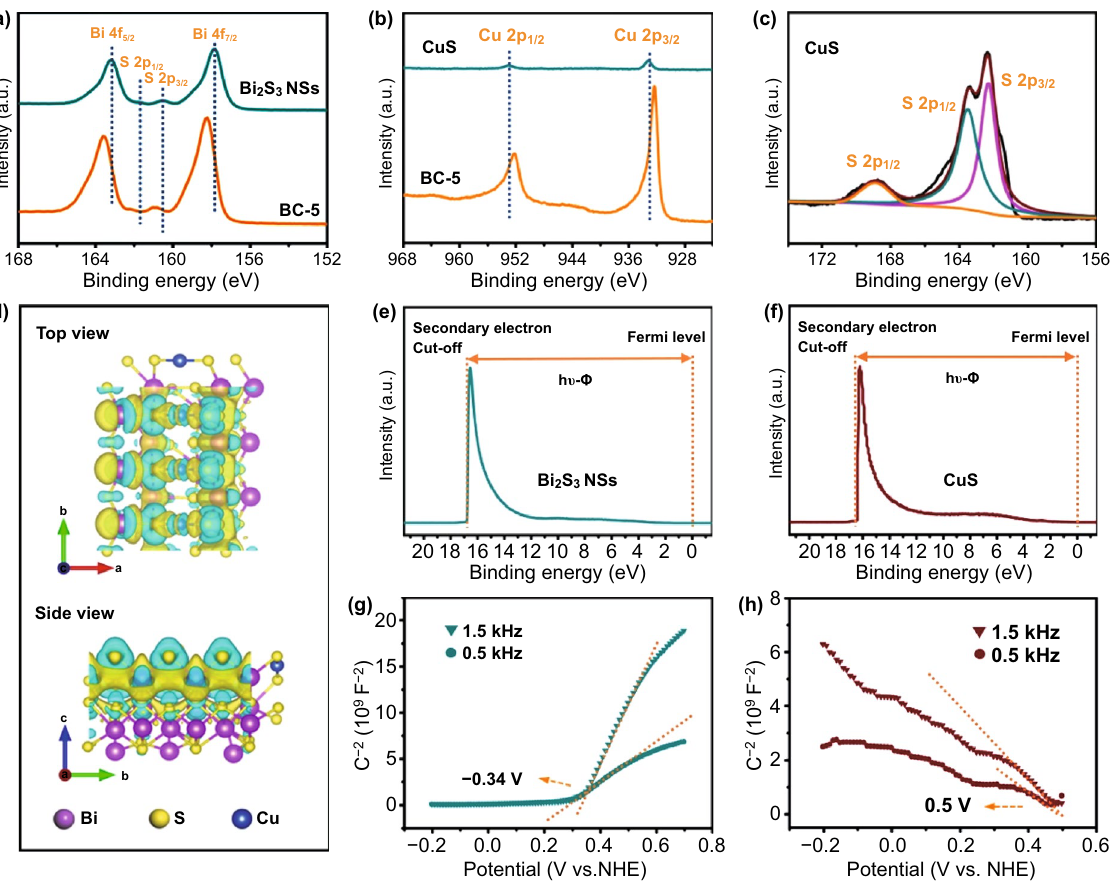
Fig. 4 Analysis of interface charge state of the heterostructure. a‑c High-resolution XPS spectra of Bi 4f, Cu 2p and S 2p of the BC-5, CuS, and Bi 2 S 3 NSs. d Charge distribution at the interface of CuS QDs and Bi 2 S 3 NSs calculated by density functional theory. UPS spectra of e Bi 2 S 3 and f CuS. Mott − Schottky plots for g Bi 2 S 3 NSs and h